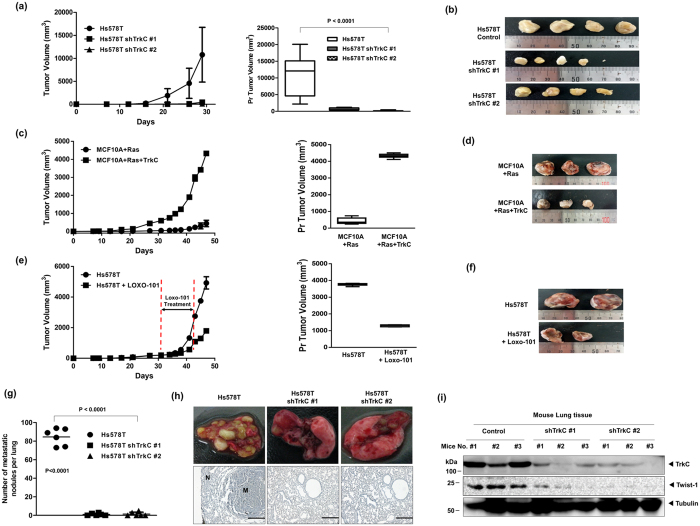
Suppression of TrkC expression inhibited the ability of Hs578T cells to metastasize from the mammary gland to the lung.(a) Volumes of primary mammary tumors formed by Hs578T control-shRNA or TrkC-shRNA cells. Each data point represents the mean of each type of primary tumor. A P < 0.0001 was considered to indicate significance for ANOVA. (b) Representative images of tumors from mice harboring Hs578T control-shRNA or TrkC-shRNA mammary tumors after tumor implantation. (c) Volumes of primary mammary tumors formed by MCF10A-Ras or MCF10A-Ras-TrkC cells. Each data point represents the mean of each type of primary tumor. A P < 0.0001 was considered to indicate significance for ANOVA. (d) Representative images of tumors from mice harboring MCF10A-Ras or MCF10A-Ras-TrkC cells. (e) LOXO-101 inhibits tumor growth in a Hs578T xenograft model. 1 × 106 cells were implanted into the mammary fat pads of mice and treated with diluent (control) or LOXO-101 (60 mg/kg/dose) twice daily for 14 days when the tumor size was 200 ± 20 mm3. (f) Representative images of tumors from mice harboring diluent (control) or LOXO-101 (60 mg/kg/dose) (g) Total number of lung metastatic nodules in each mouse in each group were counted using a dissection scope. Two populations of Hs578T cells that were independently infected with TrkC-shRNA #1 and TrkC-shRNA #2 were used in independent experiments (n = 6) and consistently yielded similar results. A P < 0.0001 was considered to indicate significance for ANOVA. (h) Representative images and H&E staining sections of mouse lung lobes 35 days after tail vein injection of Hs578T control-shRNA or TrkC-shRNA cells. N, Normal lung tissue; M, metastatic nodule. (i) Immunoblotting of the expression of TrkC and Twist-1 in tumor cells recovered from the lungs of individual mice expressing either Hs578T control-shRNA or TrkC-shRNA. Some of the bar graphs do not have visible error bars due to low values of standard error of the mean (SEM).